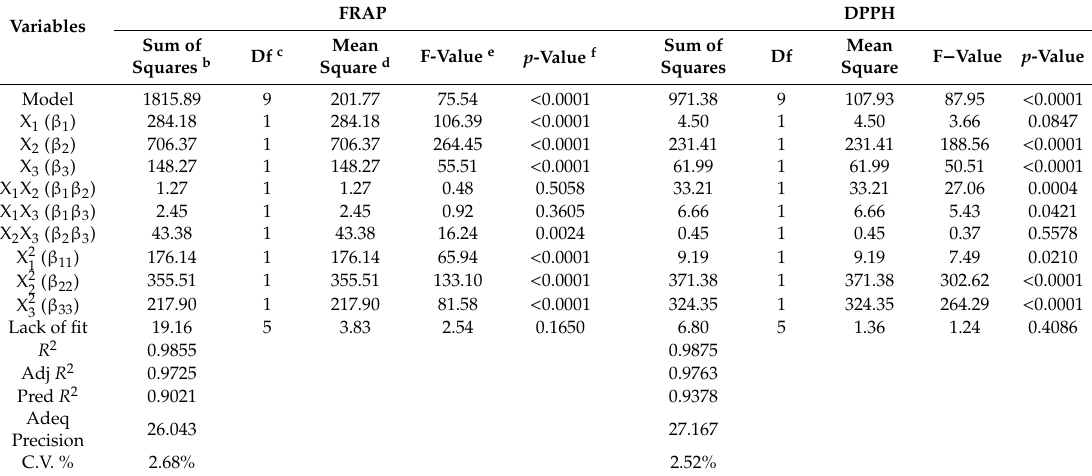
Table 5. Results of ANOVA about central composite design a